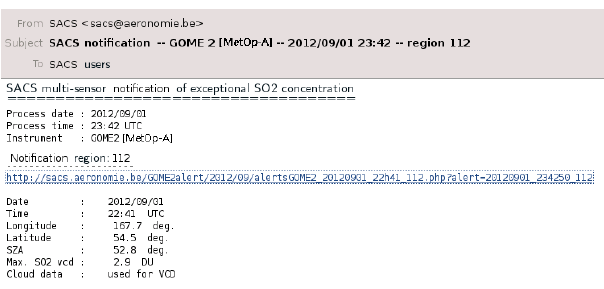
Fig. 10. Example of an email notification sent to users in the case of an exceptional SO 2 concentration